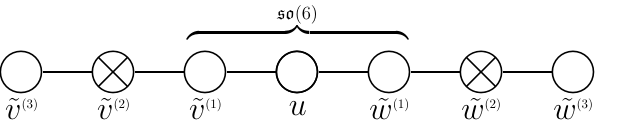
j are associated to the su (2) middle and w ( a ) realized j j 4). The three middle bosonic nodes j